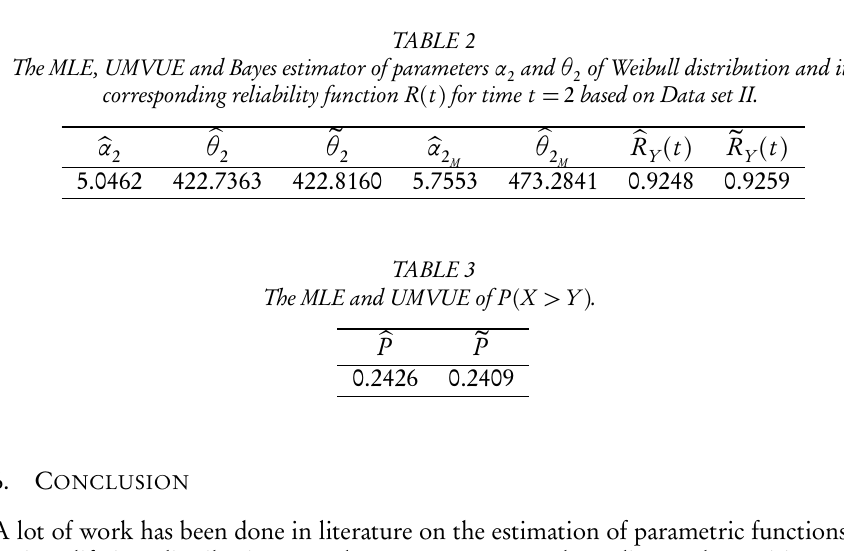
The MLE, UMVUE and MOME of parameters α corresponding reliability function R